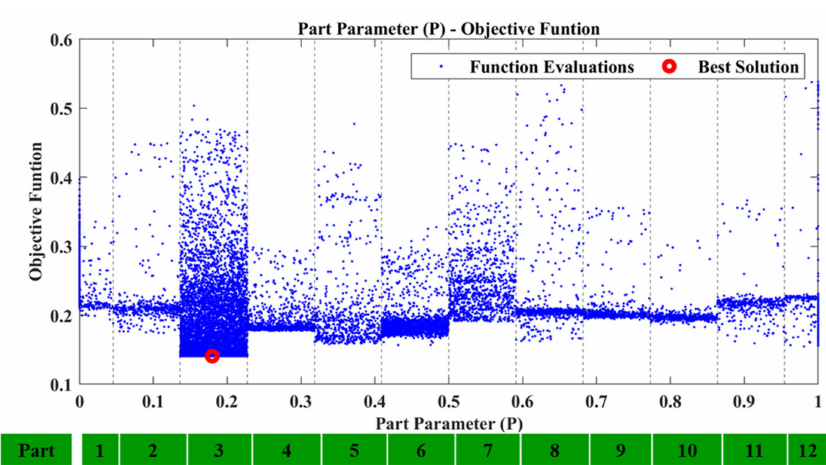
Figure 20. D3: Damaged FE model.